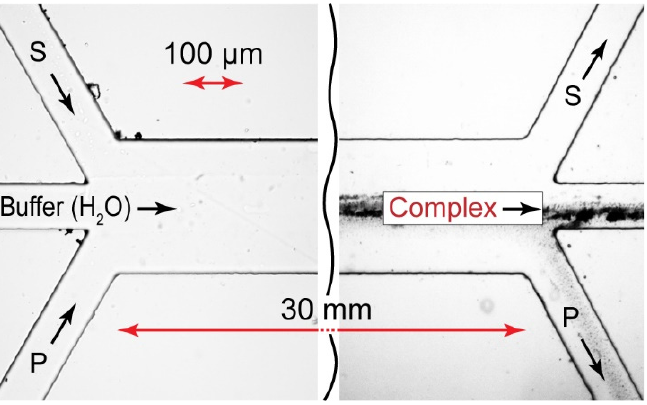
Figure 8. Ψ – Ψ‐ type microfluidic chip prototype. The testing reaction pair is PDADMAC + SDS. All the flow rates are 10 μ L/min. Samples are taken from the central output. Duration of the experiment: 15 min.